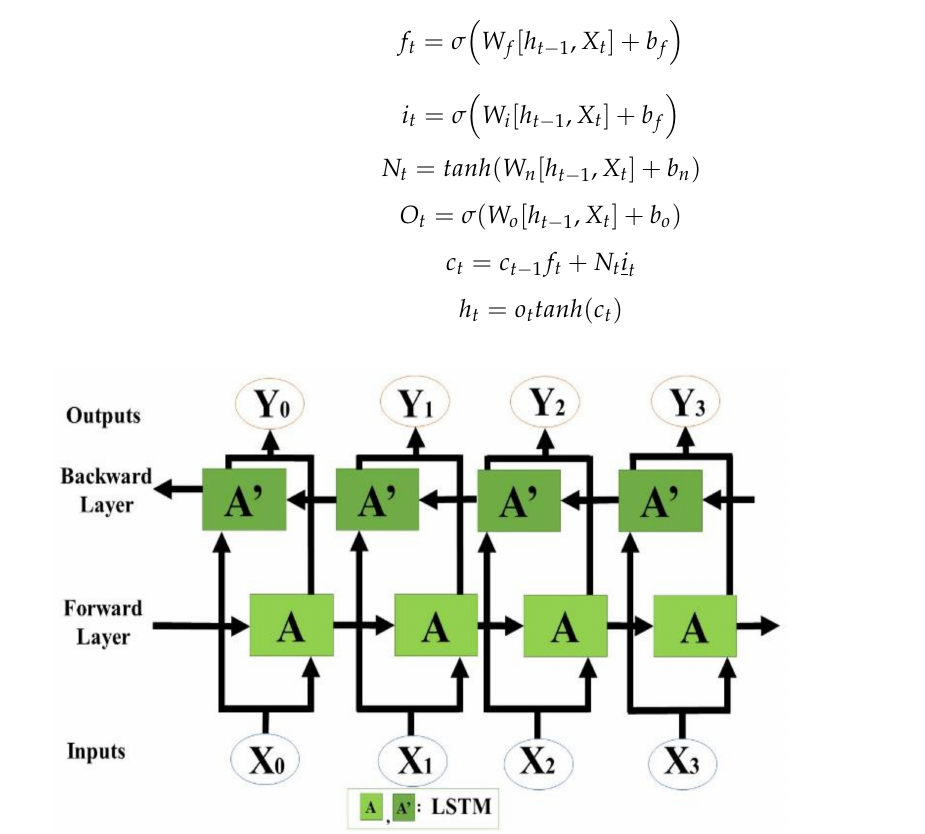
Figure 5. Structure of a bidirectional